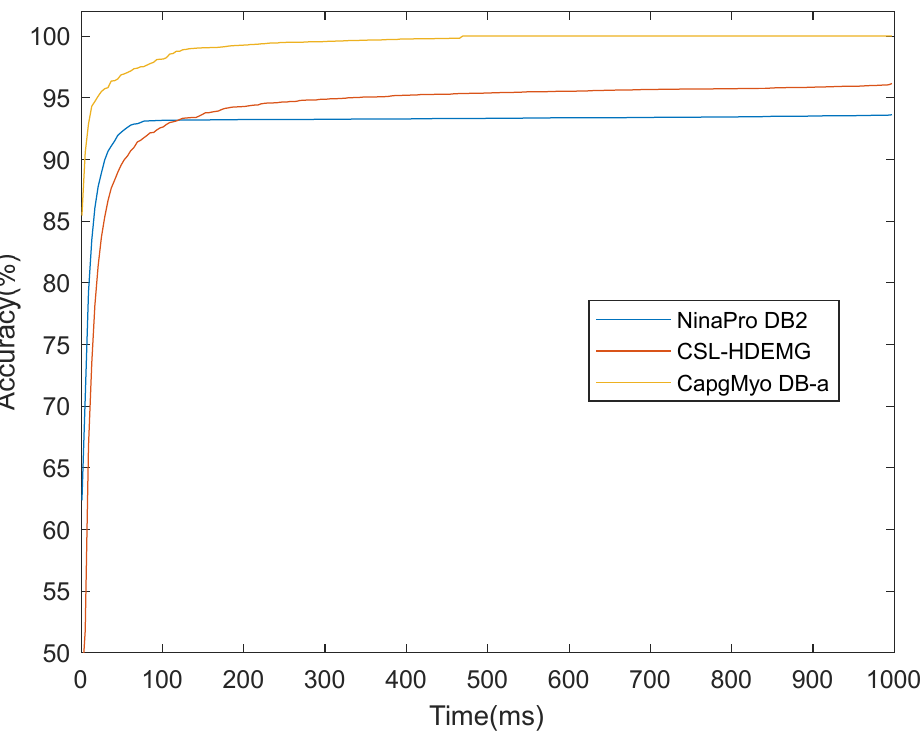
Figure 11. The recognition accuracies over different voting windows on high-density datasets NinaPro DB2, CSL-HDEMG, and CapgMyo DB-a. The recognition accuracies grow up when larger voting windows are applied.